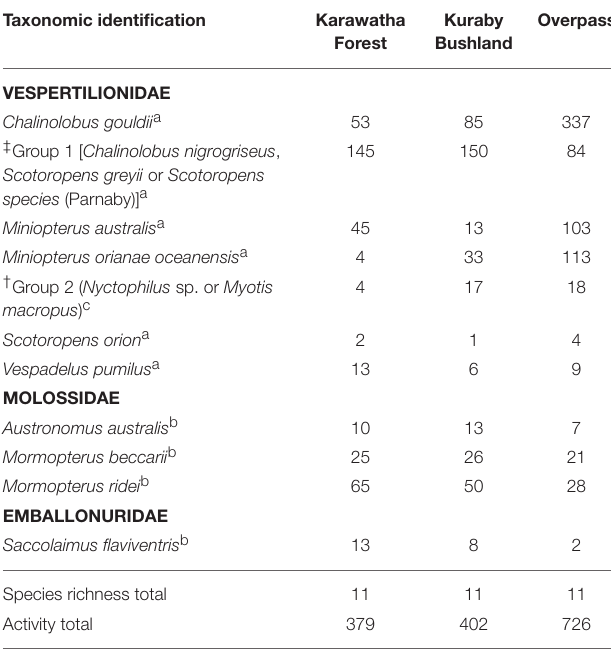
TABLE 1 | Bat species identified from the recorded echolocation calls, including total calls recorded for Karawatha, Kuraby and the